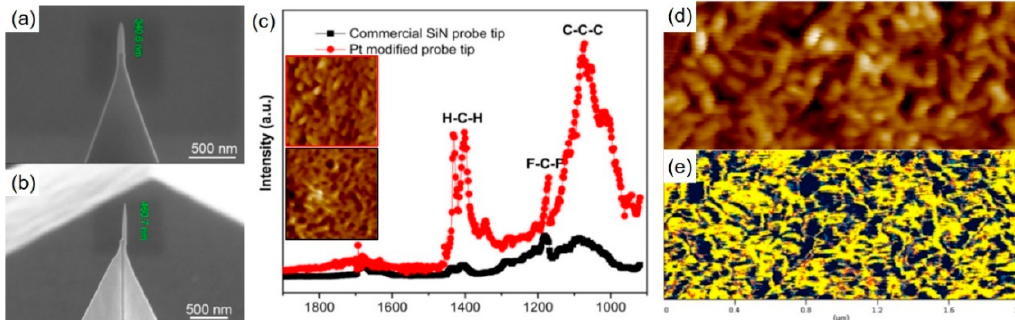
Figure 12. FEBID-based AFM-IR. ( a , b ) show two examples of Pt- and W-modified cantilevers, respectively, which were further treated via e-beam curing (EBC) to increase the electric conductivity for the required electric field enhancement during IR operation. ( c ) shows a comparison of localized nano-IR spectra on thin poly-vinylidine-fluoride (PVDF) films, performed via commercial SiN (black) and FEBID modified tips (red), where the enhancement in chemical sensitivity is clearly evident. The insets show 1.5 µ m wide height scans (same frame color as the spectra), which reveals the improved lateral resolution. ( d , e ) show the 2 µ m wide correlated height and chemical mapping image of PVDF, respectively, acquired at a constant wavenumber of 1078 cm − 1 , which indicates the asymmetric C–C stretching mode in the β -phase and allows morphology to chemistry studies. Adapted and reprinted from Qian et al., Nanotechnology 2018 [129].